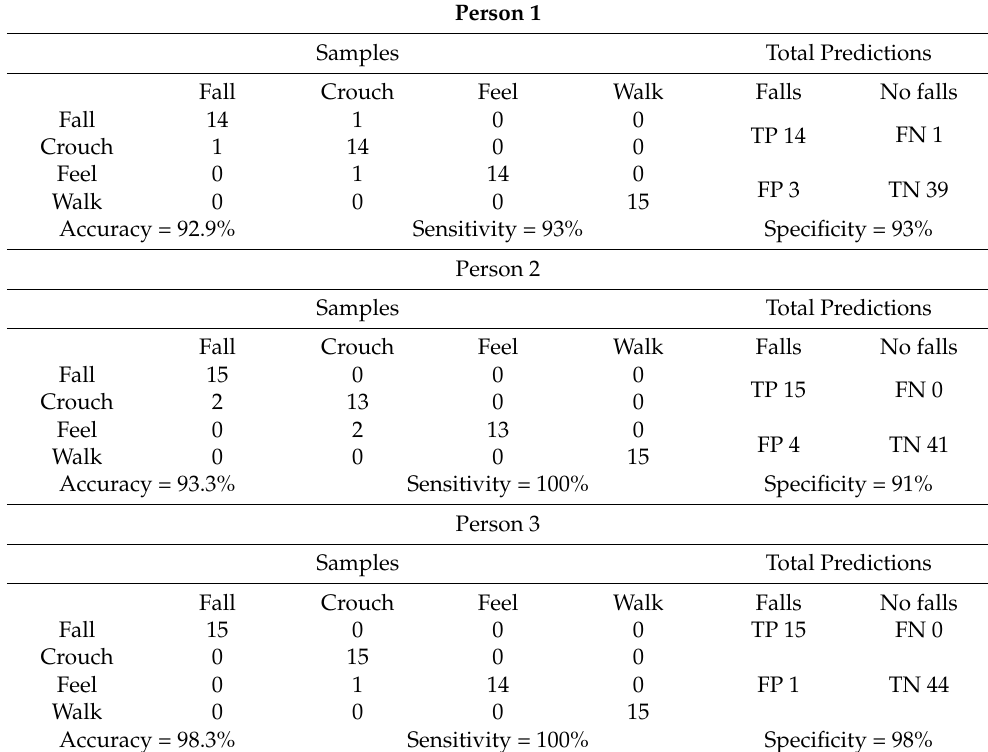
Table 1. Confusion matrix on the sampling of three